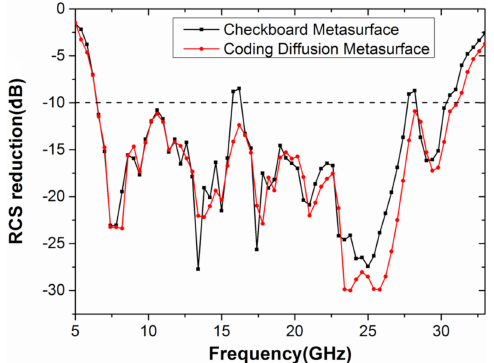
Figure 10. The monostatic RCS reduction of a checkerboard metasurface and a coding di ff use